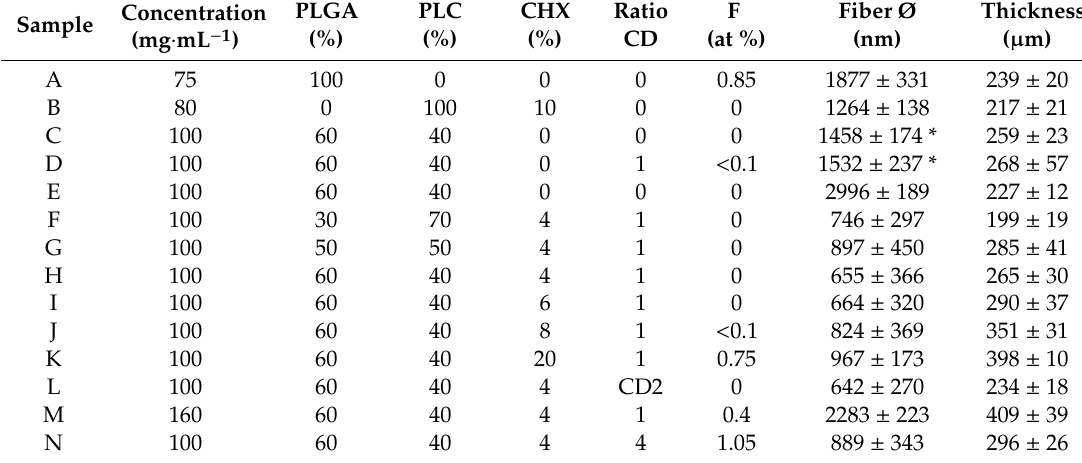
Table 1. Fiber diameter, Fluor concentration and membrane thickness, according to the formulation (% w / w), copolymers with chlorhexidine diacetate (CHX) content (% w / w) and CHX / CD